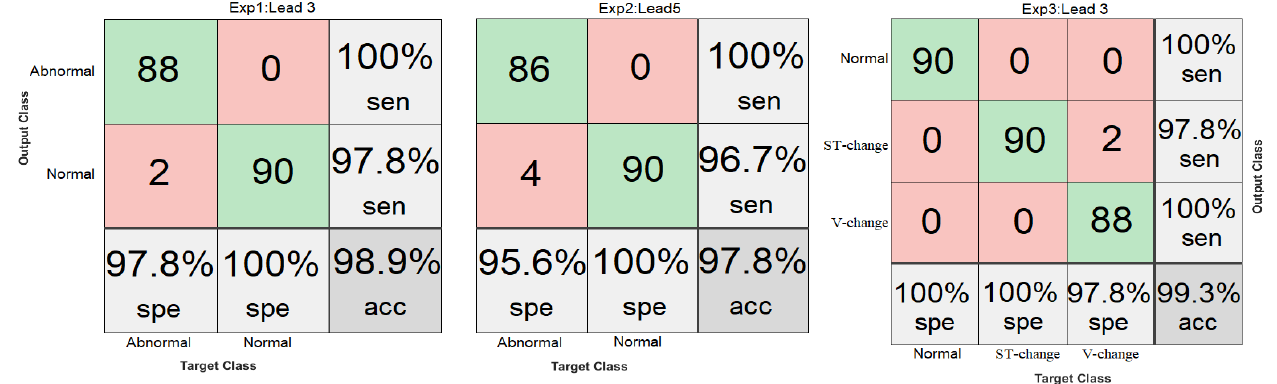
Figure 17. Confusion